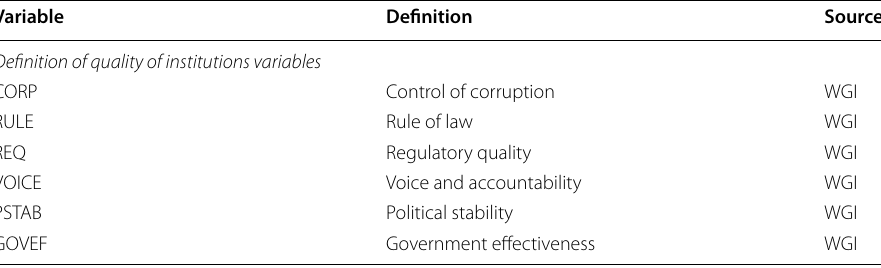
Table 1 Variables of principal component analysis